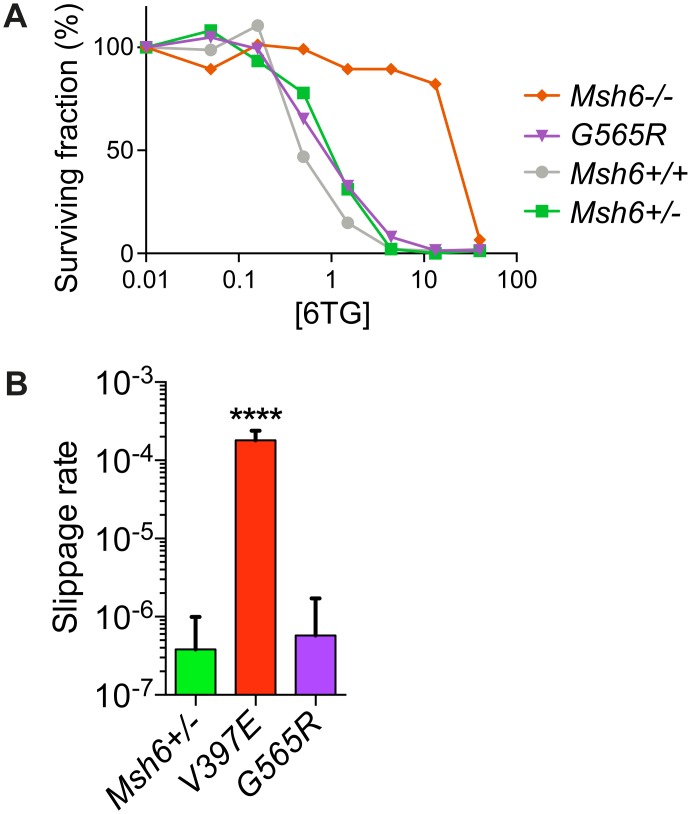
MMR capacity of Msh6G565R/- mESCs.The MMR activity of Msh6G565R/- mESCs was investigated using two assays. (A) 6TG survival assay. The colony-forming capacity of Msh6G565R/- mESCs as well as MMR-deficient Msh6-/- and MMR-proficient Msh6+/- and Msh6+/+ cells was determined in response to increasing doses of 6TG. (B) MSI in the Msh6G565R/- mESCs was investigated using the (G)10-neo slippage reporter. The slippage rate (the emergence of a Geneticin-resistant cell per cell division) in Msh6G565R/- cells was compared to the rate in MMR-proficient Msh6+/- and MMR-deficient Msh6V397E/- control cell lines. Statistical differences were calculated using one tailed, unpaired t-test with Welch’s correction. **** indicates significantly higher than the mismatch repair proficient Msh6+/- control: P<0.0001.